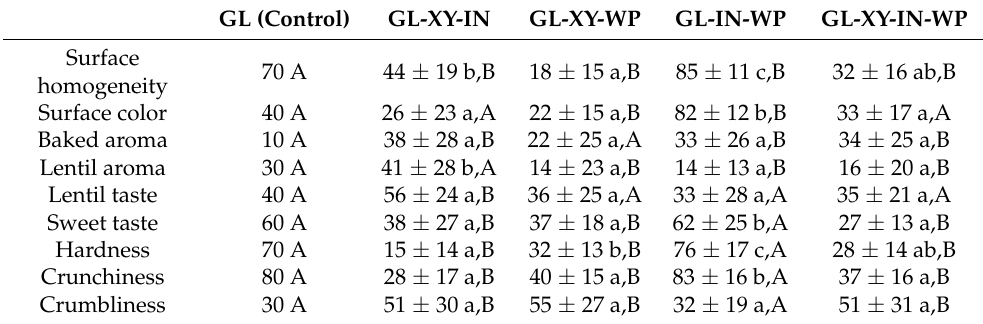
Table 8. Sensory properties of green lentil